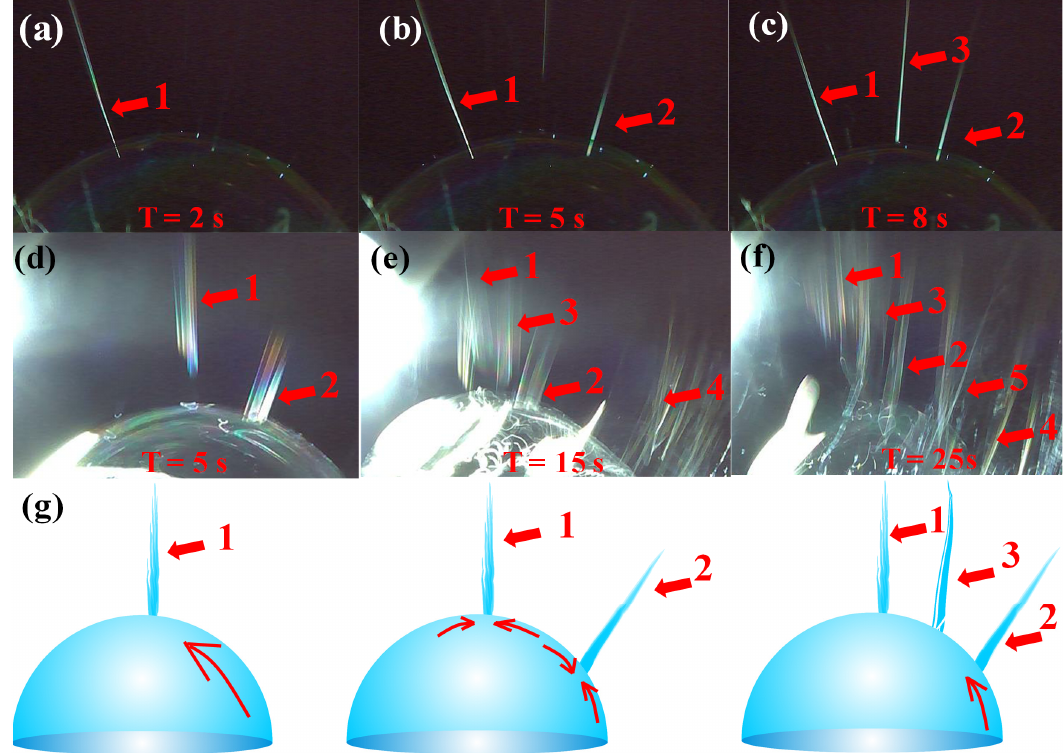
Figure 9. The law of jets formation in critical bubble electrospinning: images of ( a ) the first jet , ( b ) the second jet and ( c ) the third jet generated for 6 wt % PVA solution; images of ( d ) the first jet , ( e ) the second jet and ( f ) the third jet generated for 8 wt % PVA solution; ( g ) illustrations of the “array in two points” law.